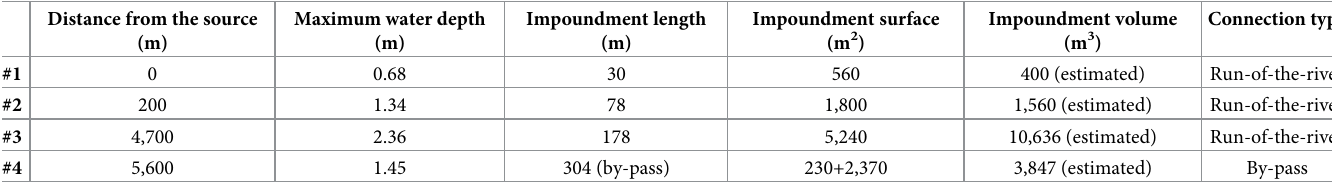
Table 1. Impoundment